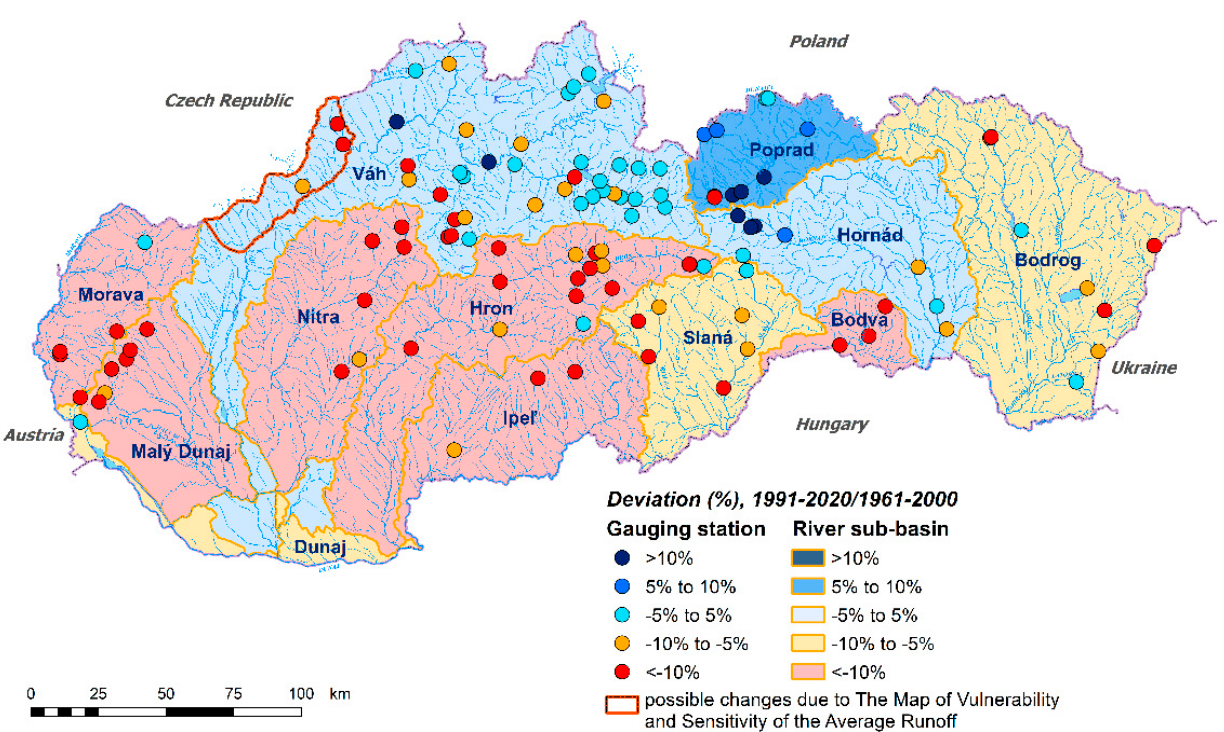
Figure 6. The flow rates average deviation (%) for the area of Slovakia and its river sub-basins and evaluated water-gauging stations for the period 1991–2020 (reference period 1961–2000).